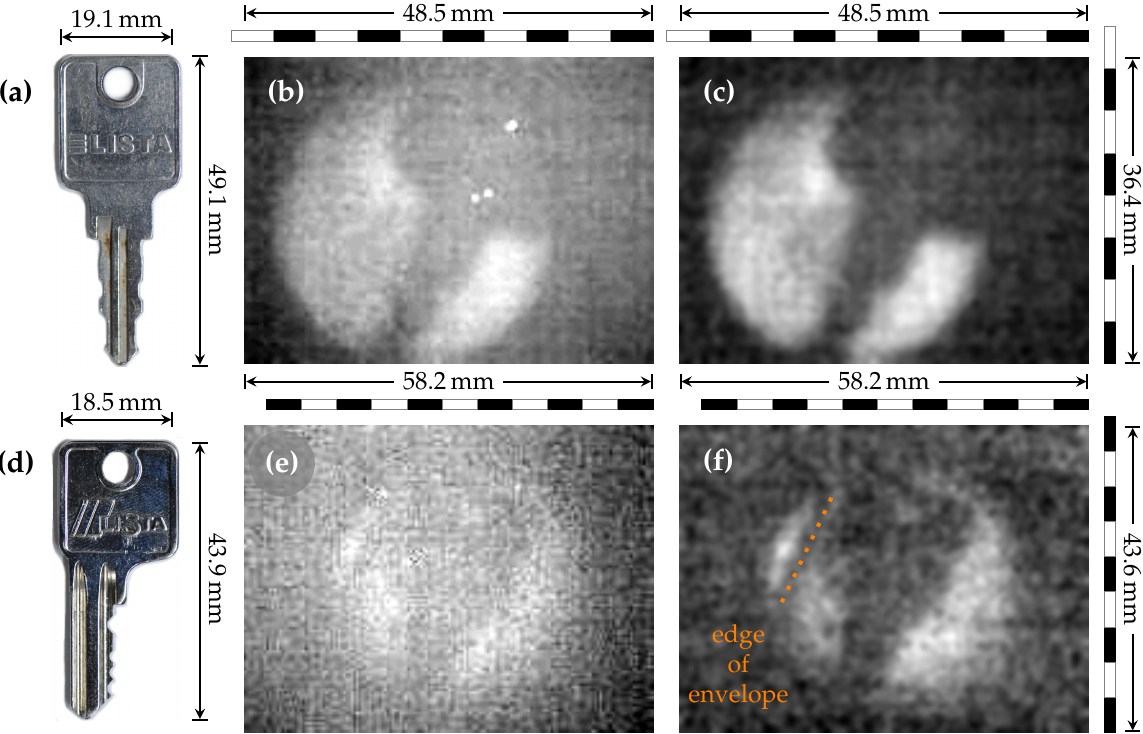
Figure 5. Imaging of the metal keys. Photography of the keys with rough dimensions ( a , d ), raw THz images ( b , e ) of the keys, and post-processed THz images ( c , f ) of the keys with dead pixel removal. A key can still be resolved within a standard paper envelope ( e , f ), with the edge of envelope marked ( f